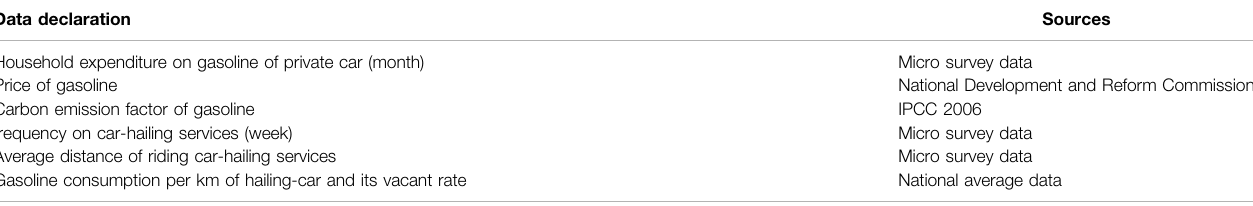
TABLE 2 | Data declaration of transportation carbon emissions estimation.